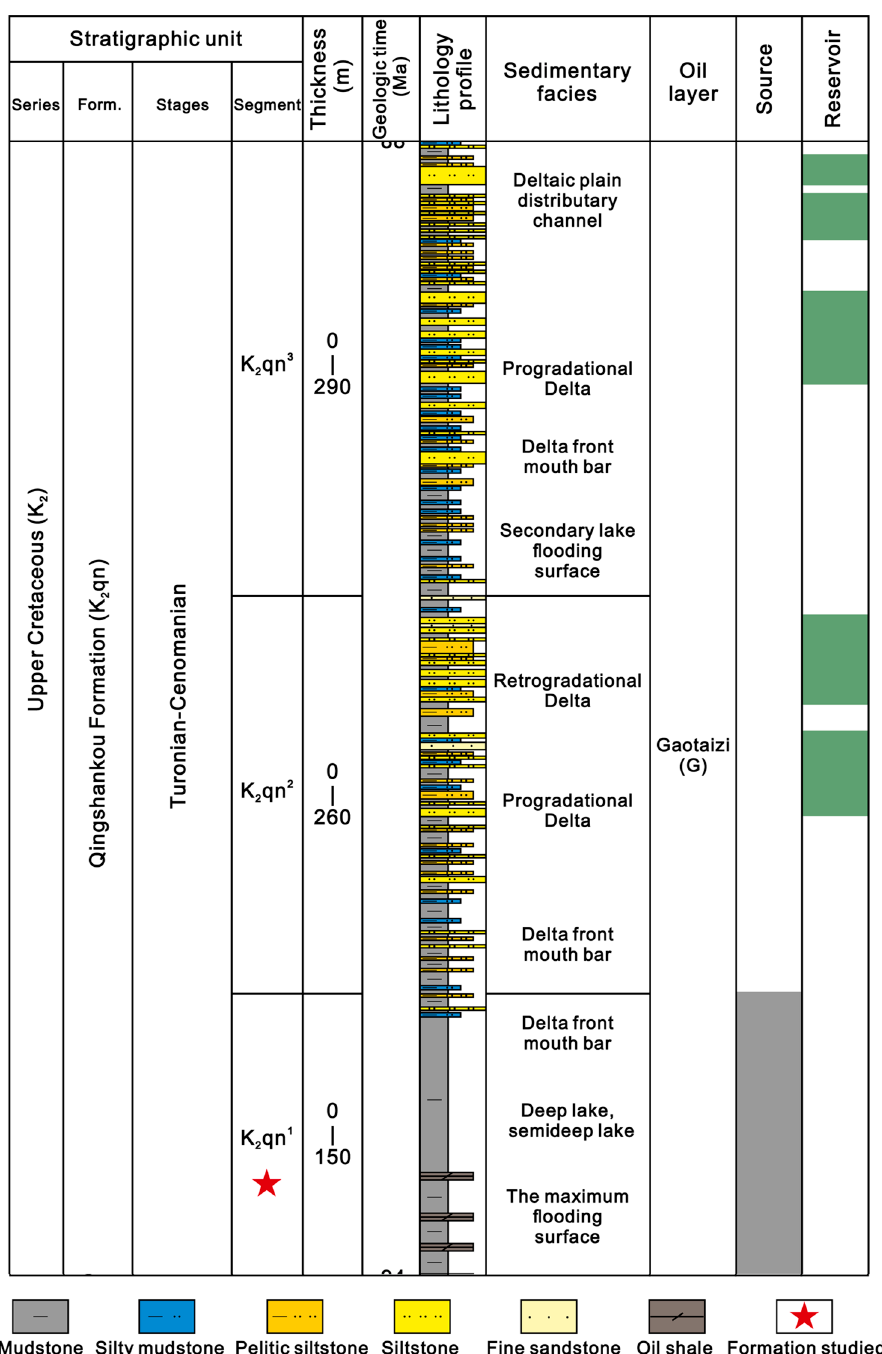
Figure 2. The strata and sedimentary characteristics of the Qingshankou Formation in western Songliao Basin (modified from Liu et al., 2019